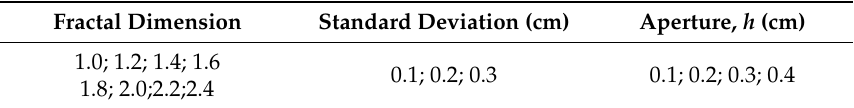
Table 2. Parameters of the synthetic fractures.